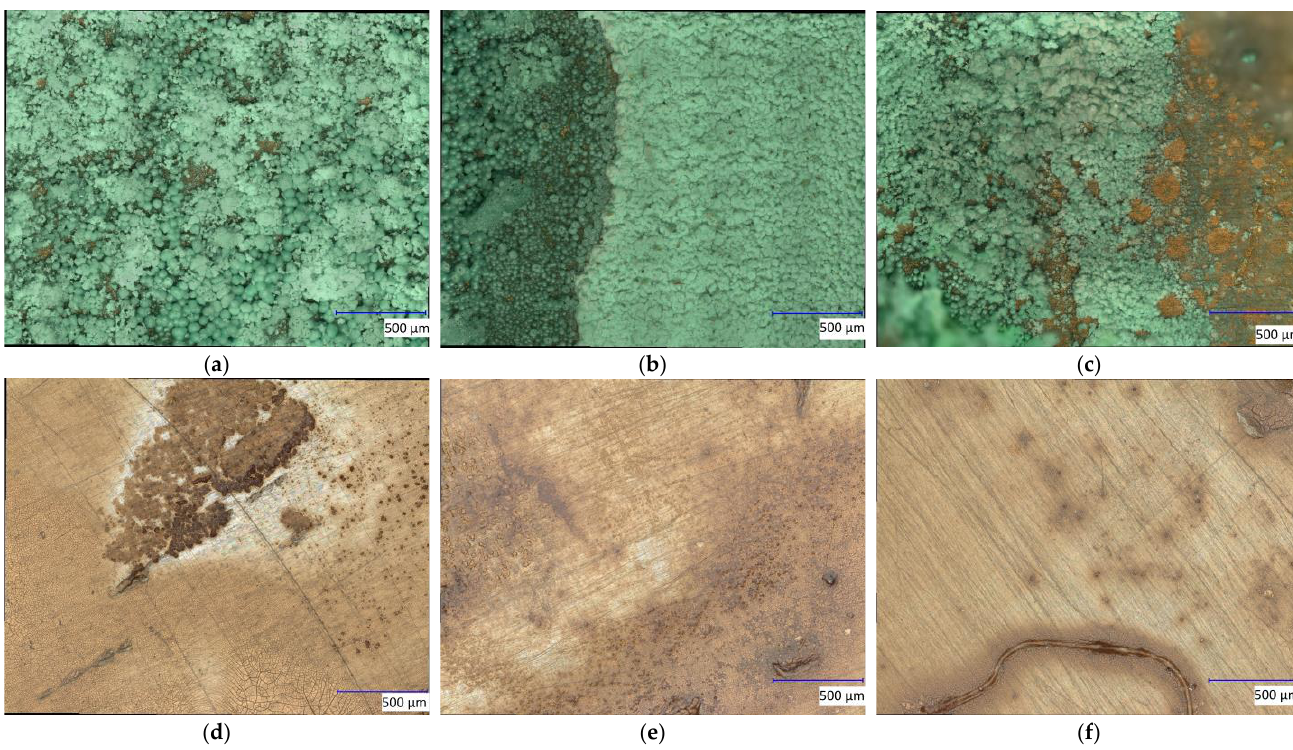
Figure 6. Microscope images of the copper ( a – c ) and iron patinas ( d – f ) before plasma treatment ( a , d ) and after 30 min ( b , e ) and 60 min ( c , f ) of Varigon plasma at low-pressure. This plasma influence led to a darker discoloration of the copper nitrate patina over the treatment times. The iron acetate patina showed less significant alterations with increasing treatment time. Only a slight grayish color change in the patina can be seen.